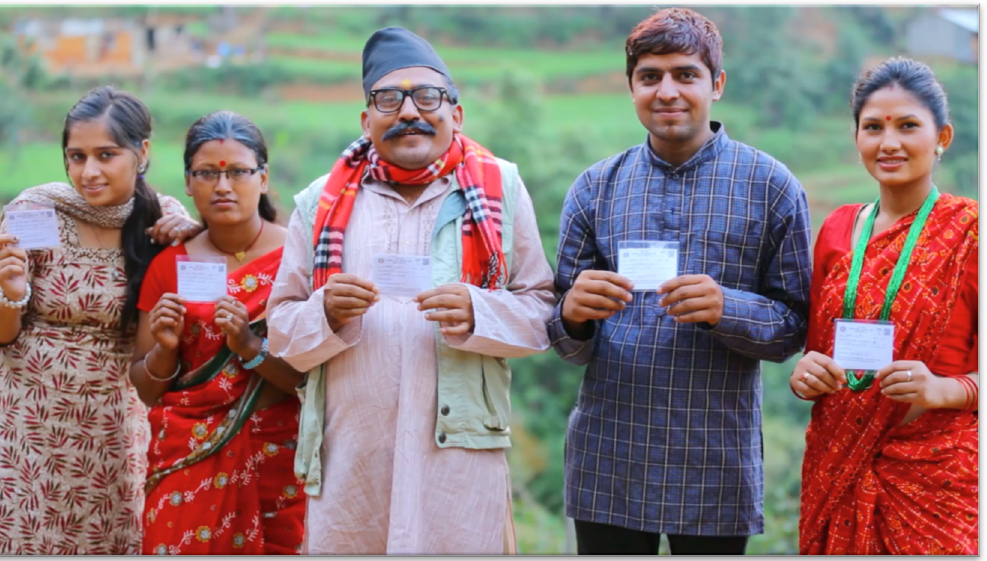
Figure 2. A national health insurance program in Nepal: Your Health is Our Concern. Source: A computer screen capture of an insurance program promotional video entitled ‘ Gajjabko Card, ’ or ‘The Amazing